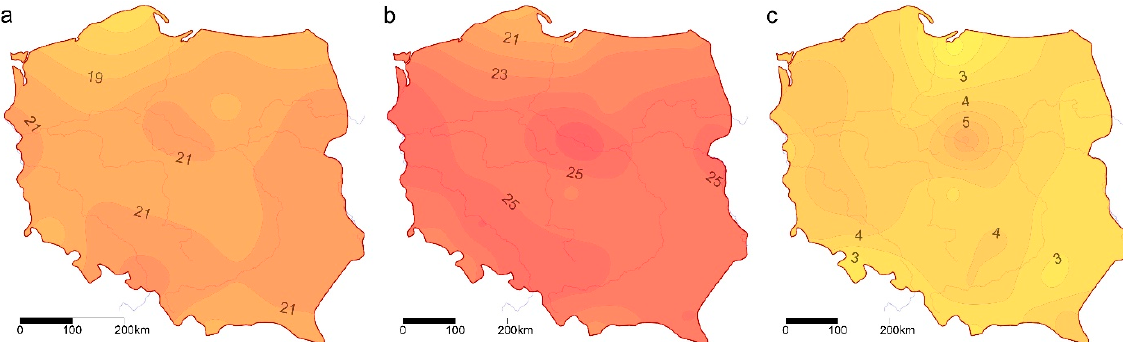
Figure 2. Mean UTCI in the summer season in the years 1966–2019 ( a ), mean UTCI in summer 2019 ( b ), and anomalies ( c ).